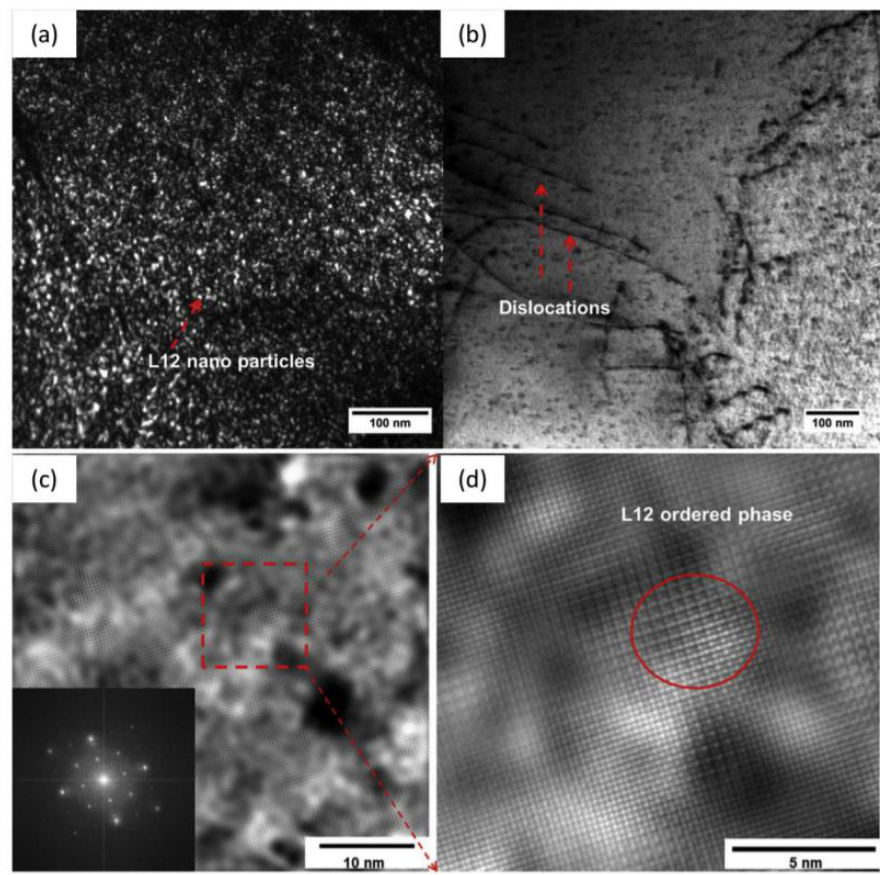
Figure 17. ( a,b ) The dark and bright field TEM image of the Al 0.5 CoCrCuFeNi HEA deformed at 600 °C. ( c,d ) The high-resolution TEM (HRTEM) images orientating in the (001) zone axis and the corresponding electron-diffraction pattern. Zoom-in images show the structure of the ordered L1 2 phase (reproduced from Reference [155] with permission).